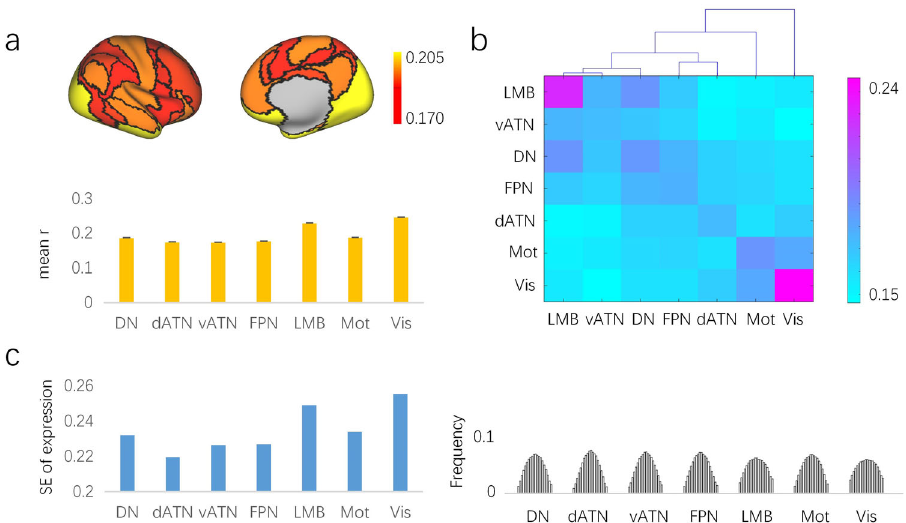
Fig. 3 The expression heterogeneity of seven networks in the human cerebral cortex. a Mean correlation coef fi cient of gene expression of samples within each network. b The hierarchical clustering of gene expression between networks. c The standard error of gene expression levels in samples of each network and their corresponding distribution. DN default-mode network, dATN dorsal attention network, vATN ventral attention network, FPN frontal parietal network, LMB limbic network, Mot motion network, Vis visual